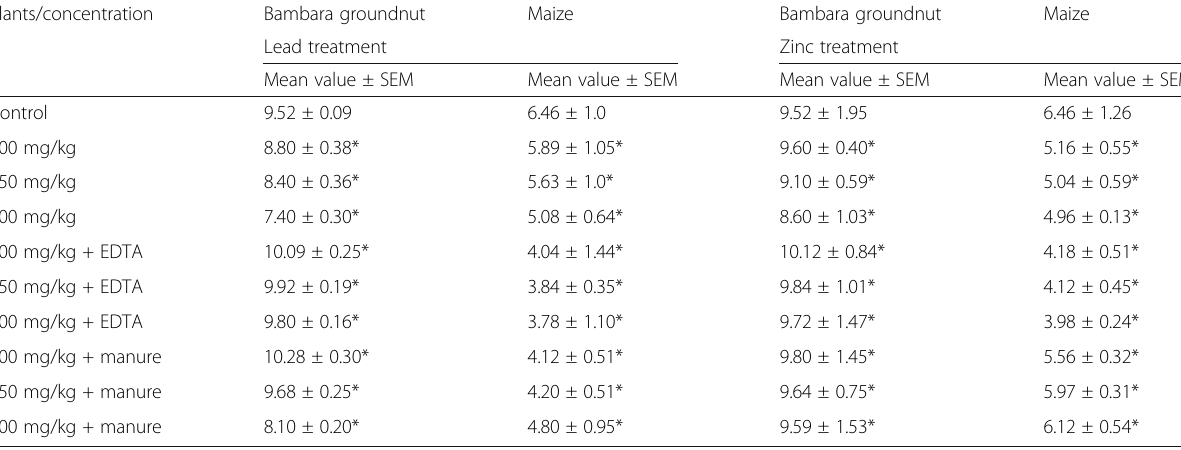
Table 5 Effect of lead and zinc concentration on total protein of the test plants